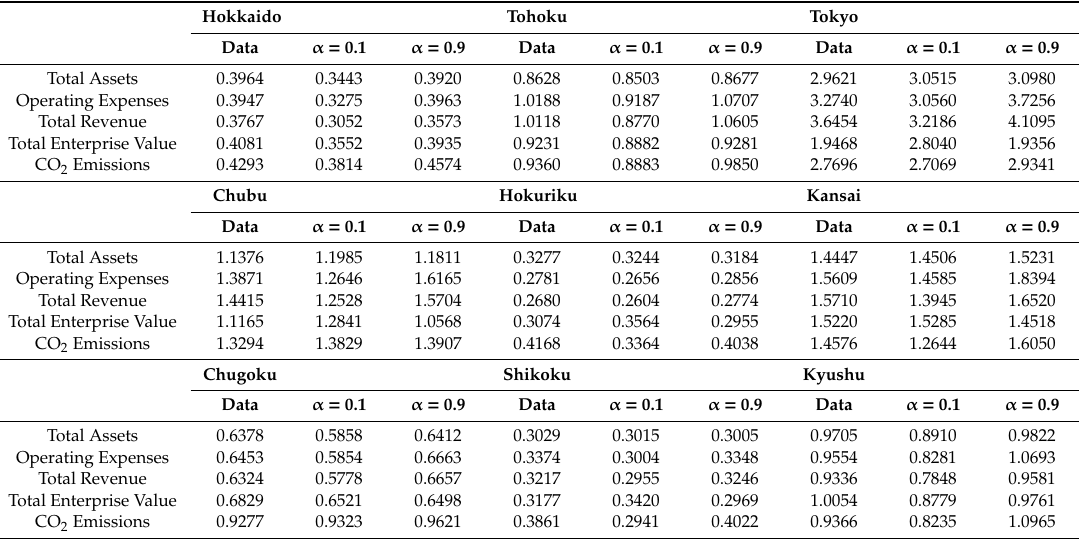
Table 5. Observed and Predicted Values by Exponential Smoothing (2015).